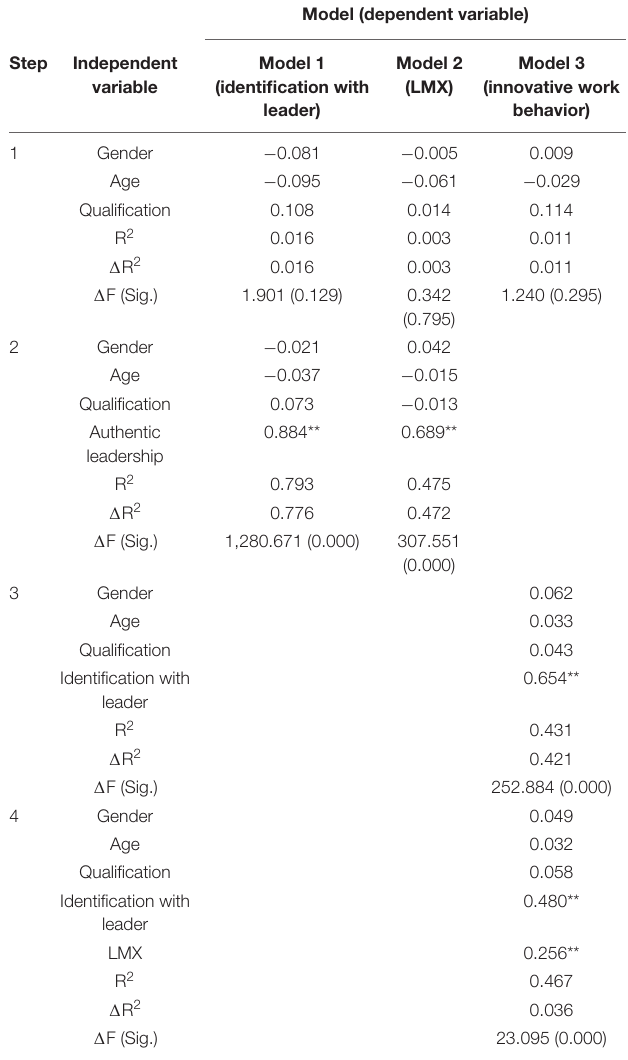
TABLE 6 | Hierarchical regression